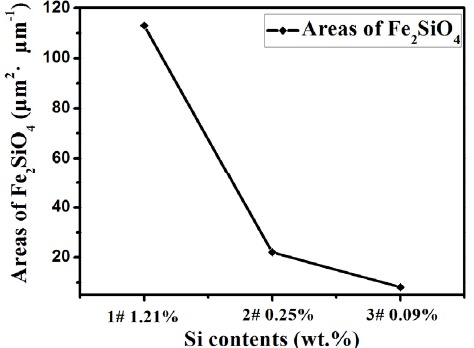
Figure 5. The areas of Fe 2 SiO 4 in three tested steels.